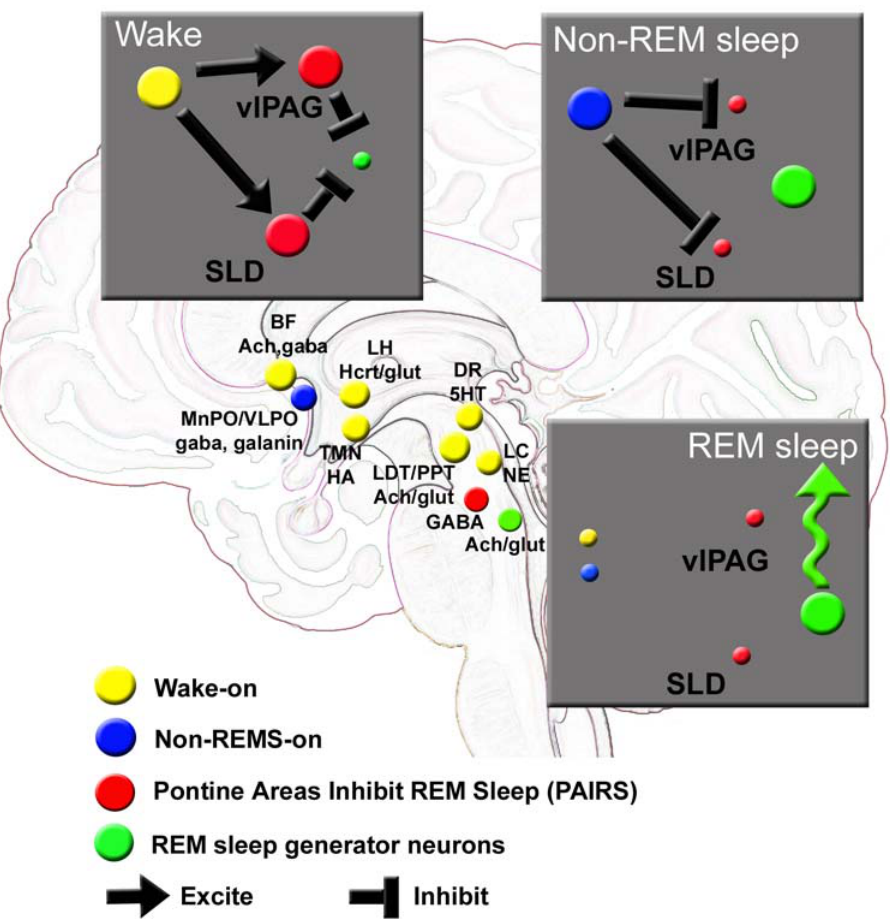
Figure 15. Model of neuronal populations that regulate wake, non-REM sleep and REM sleep (9, 13, 16). There are several neuronal populations that are considered to generate wakefulness and these are identified in yellow. Neurons that are considered to generate non-REM sleep are identified in blue. Both of these neuronal populations act on neurons in the pontine brainstem (red) and influence the generation of rapid-eye movement sleep (REM sleep). Wake-on neurons inhibit REM sleep by activating pontine GABA neurons in the pons. The strength of the excitatory input to the pontine GABA neurons influences REM sleep. A strong input will inhibit REM sleep while a weakened input will facilitate it. During non- REM sleep the excitatory input to the pontine GABA neurons is lost and is replaced by a strong inhibitory input. This enables REM sleep generator neurons (green) to become active and when sufficient numbers of these are activated then REM sleep ensues. In the present paper we tested this model by lesioning the neurons in the ventral lateral periaquaductal gray area (vlPAG), and found that REM sleep was significantly increased. When these neurons were lesioned in the hypocretin knockout mice (HCRT- ko ) then the REM sleep increase was exacerbated compared to HCRT-ko mice without vlPAG lesion. The SLD has been lesioned in rats (12,16) but not mice and there is an increase in REM sleep supporting the hypothesis of PAIRS. Abbreviations: Ach=acetylcholine; BF=basal forebrain; DR=dorsal raphe; GABA=gamma amino butyric acid; GLUT=glutamic acid; HA=histamine; HCRT=hypocretin; LC=locus coeruleus; LH=lateral hypothalamus; MnPO=median preoptic nucleus; NE=norepinephrine; LDT=lateral dorsal pontine tegmentum; PPT=pedunculopontine tegmentum; SLD=sub lateral dorsal nucleus; TMN=tuberomammillary nucleus; vlPAG=ventral lateral periaquaductal gray; VLPO=ventral lateral preoptic